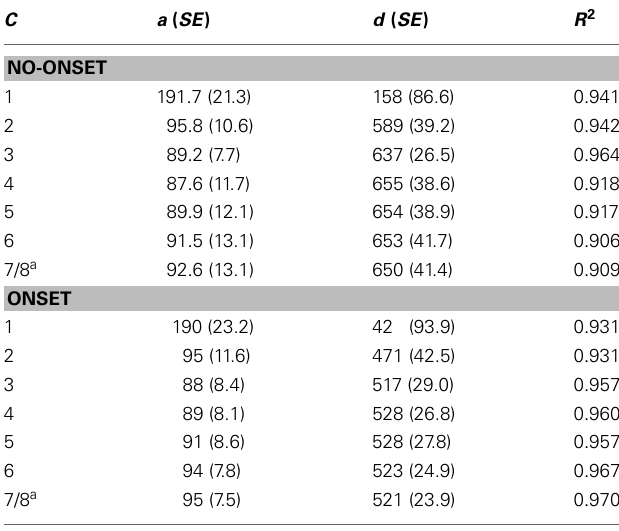
Table 6 | Summary of 16 regression analyses predicting RT in Experiment 3 separately for onset and no-onset targets for various priority tag